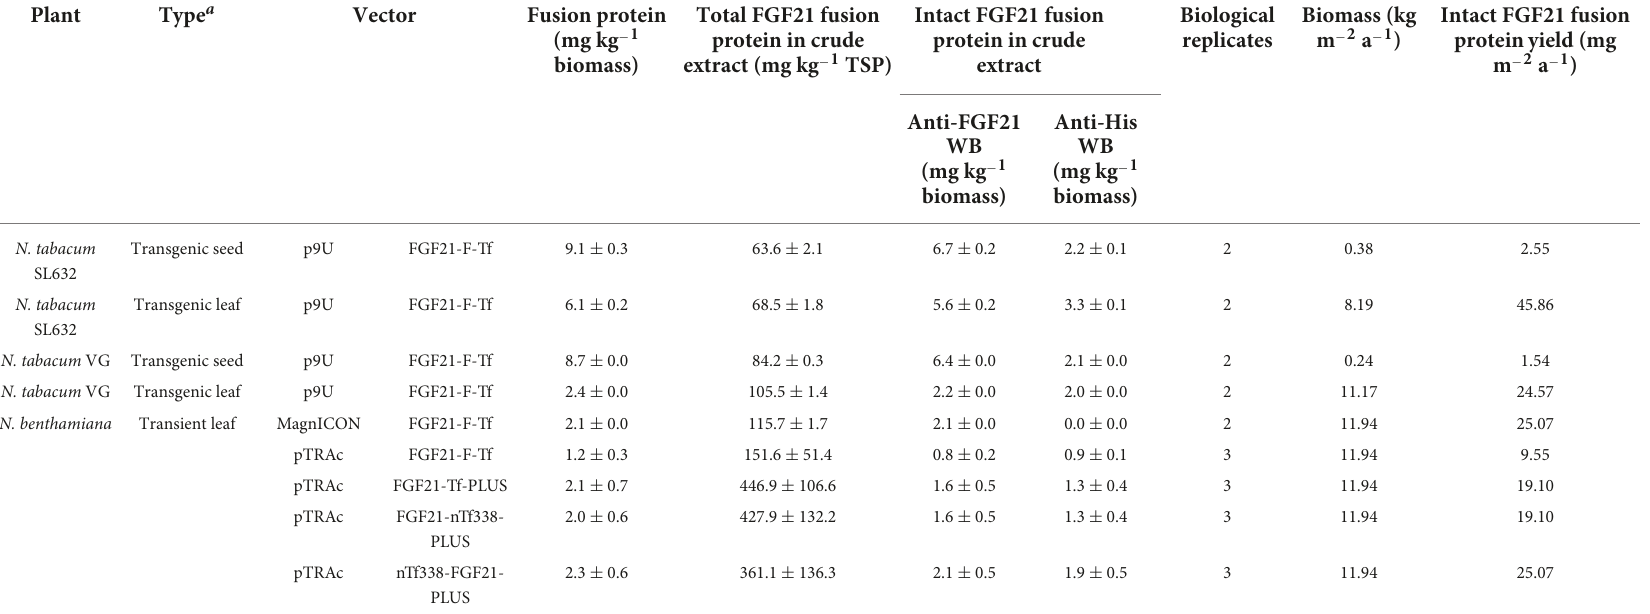
TABLE 3 FGF21 accumulation level of FGF21-transferrin fusion constructs in crude extract. Plant